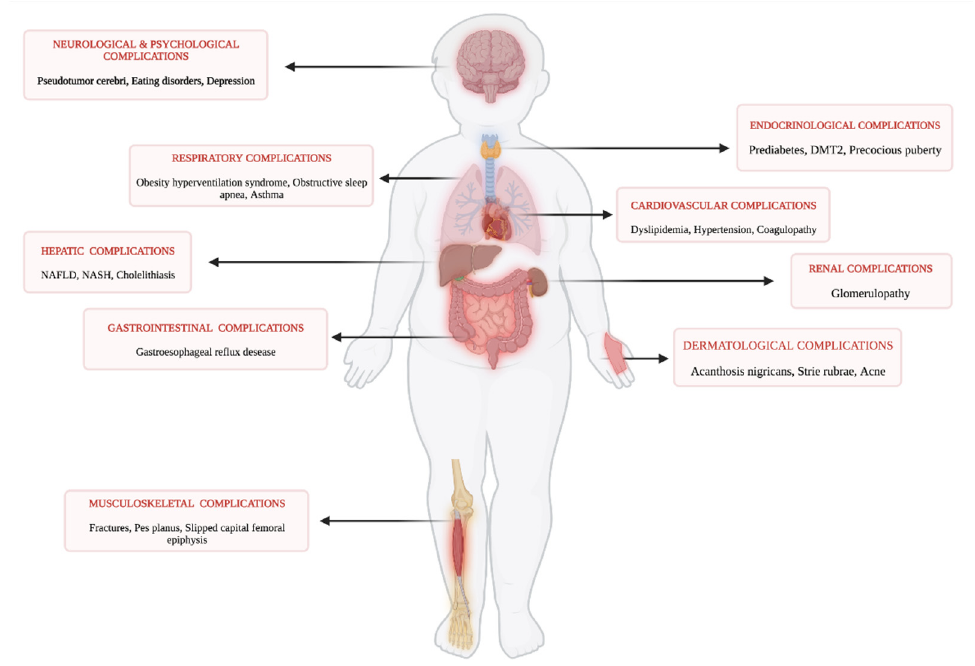
Figure 1. Multiorgan complications related to obesity in children and adolescents (created with BioRender.com, accessed on 1 July 2022).